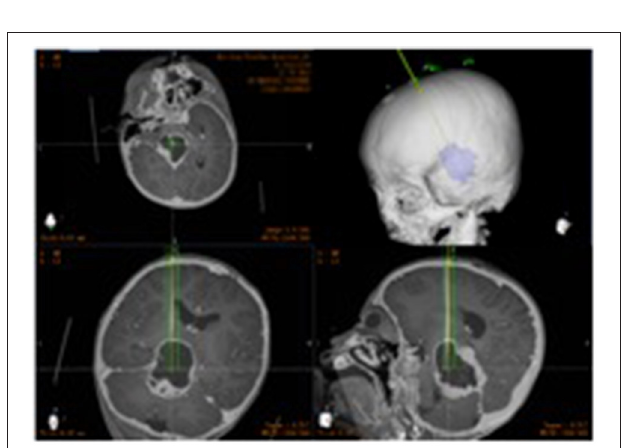
FIGURE 2 | The target and cranial path before surgery.